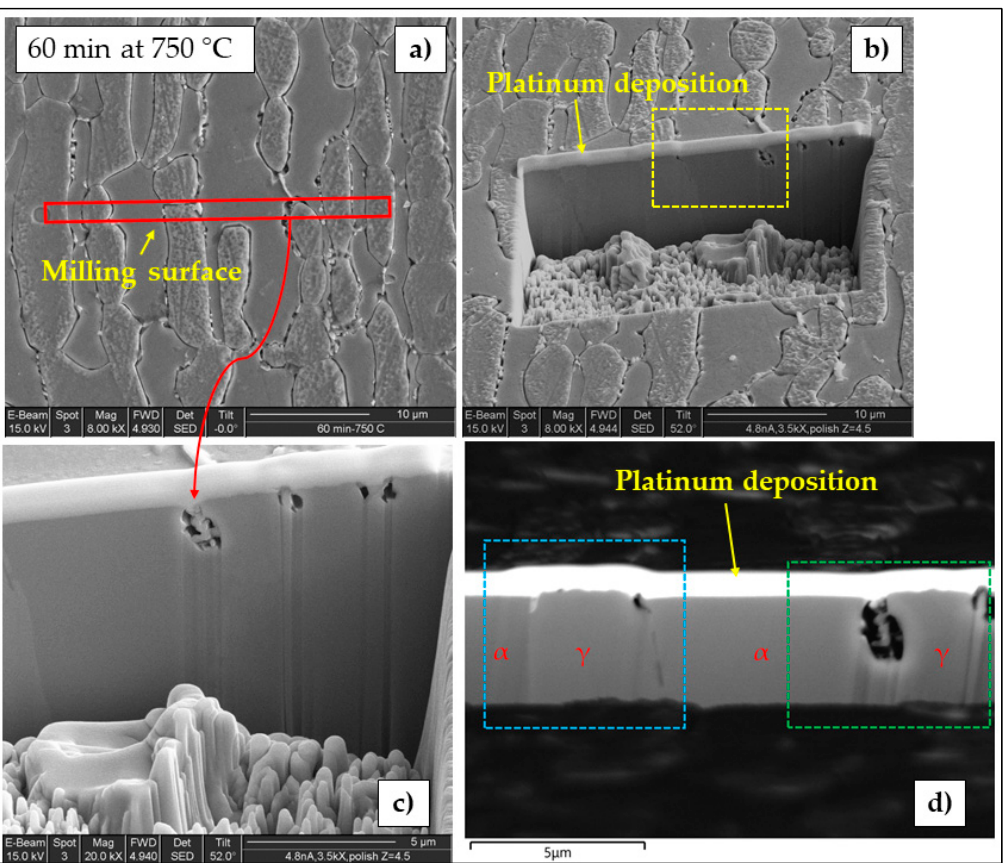
Figure 13. FEG-SEM images obtained on LDSS 2404 aged 60 min at 750 °C, after DL-EPR test, and before ( a ) and after ( b , c ) FIB milling. In ( d ) SEM-BSE tilted image of intergranular corrosion (IGC) attacks evidenced with the yellow rectangle in ( b ).